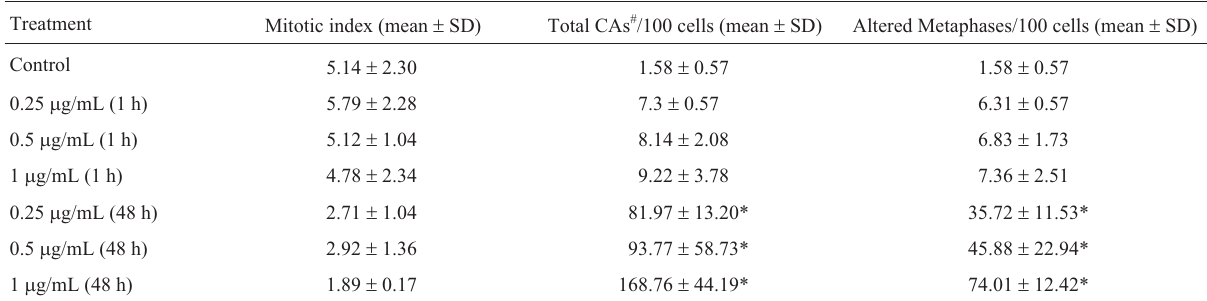
Table 1 - Mitotic indexes, chromosome aberration distribution (CAs), total CAs and altered metaphases in cultures treated with etoposide. Independent experiments were performed with blood samples from three individuals. Treatment